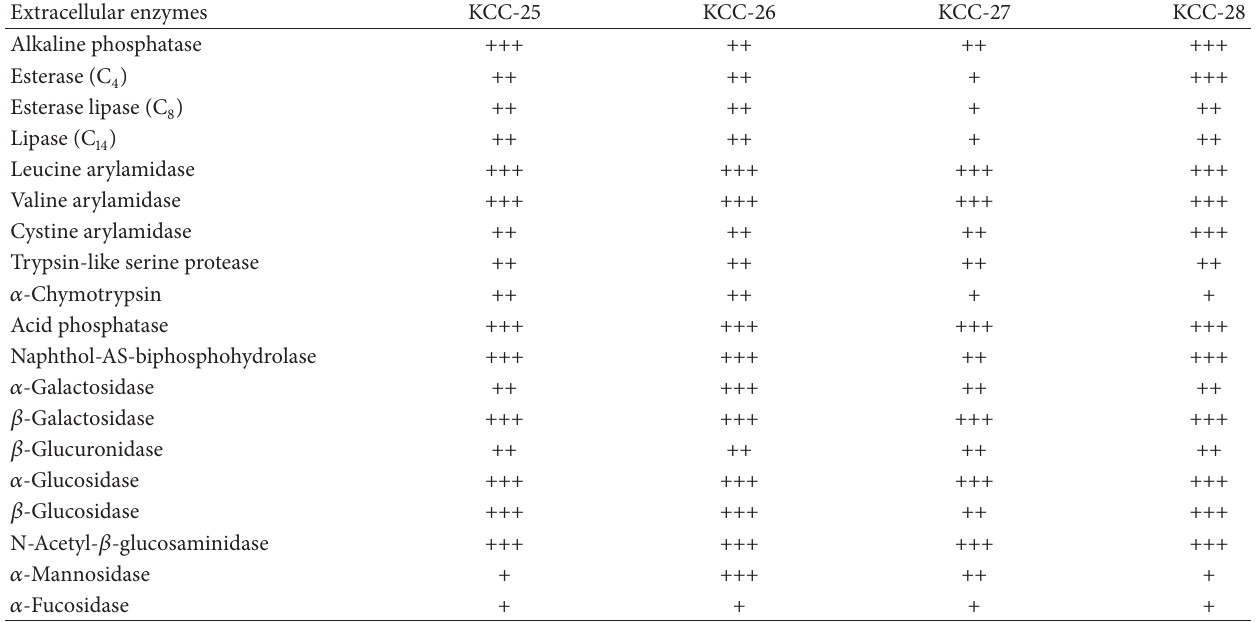
Figure 5: (a) Growth of KCC-25, KCC-26, KCC-27, and KCC-28 in gastric juice (pH-2 and pH-3) stress condition. (b) Cholesterol lowering property of Lactobacillus strains. abcd Different letters within treatment represent significant difference ( 𝑝 < 0.05 ). Table 4: Extracellular enzymes production by isolated strains.